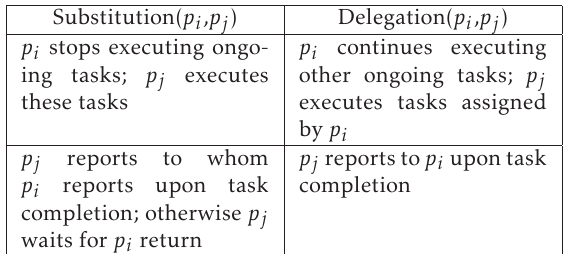
Table 1. Substitution versus